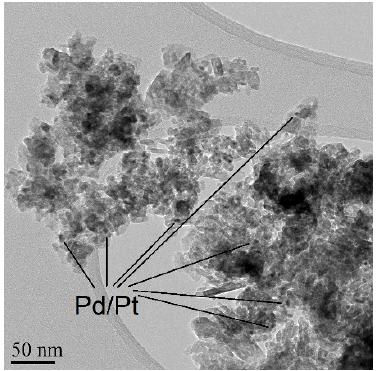
Figure 14. TEM image from the fresh natural gas catalyst.